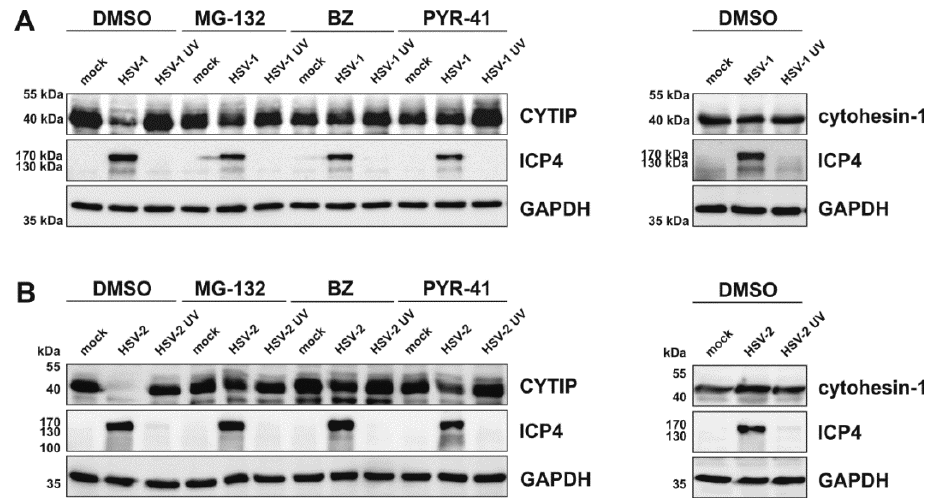
Figure 11. HSV-1 and HSV-2 induce proteasome- and ubiquitin-dependent degradation of CYTIP in transfected HEK293T cells. HEK293T cells were transfected with 1 µg of plasmid DNA encoding CYTIP (left panels) or cytohesin-1 (right panels). After 24 h, cells were mock-treated or infected with ( A ) HSV-1 (MOI of 2) or HSV-1 UV-inactivated virions (MOI of 2; 8 × 0.12 J/cm 2 ) and ( B ) HSV-2 (MOI of 5) or HSV-2 UV-inactivated virions (MOI of 5; 8 × 0.12 J/cm 2 ). Cells were treated with or without the proteasomal inhibitors MG-132 (10 µM) or bortezomib (BZ; 2 µM) 1 hpi, or the ubiquitination inhibitor PYR-41 (80 µM) 4 hpi. As control, cells were treated with DMSO. Cells were harvested 18 hpi and protein lysates were subjected to Western blot analysis using equal amounts of protein loaded on a 12% acrylamide SDS-gel. Expression levels of CYTIP, cytohesin-1, ICP4 as infection control, or GAPDH as loading control, were monitored using specific antibodies. The experiment was performed three times independently and representative data are shown.